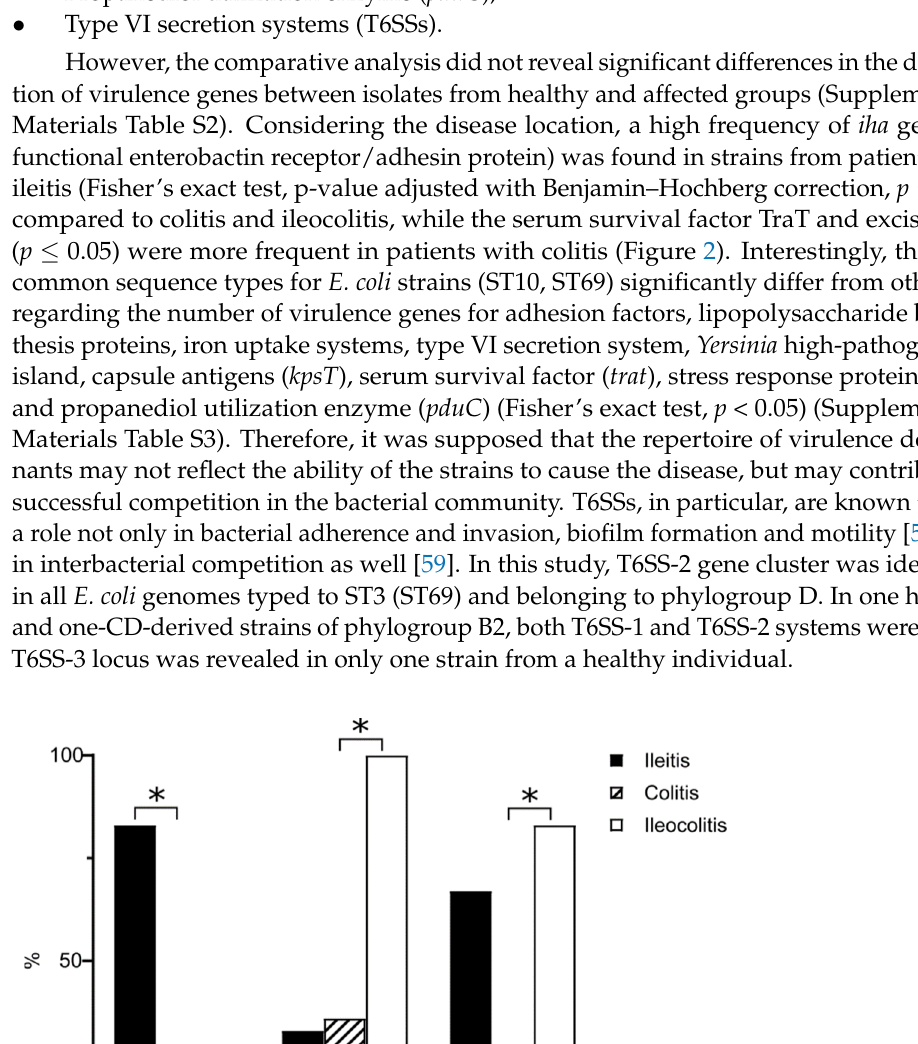
ity to inhibit the growth of the target strain.